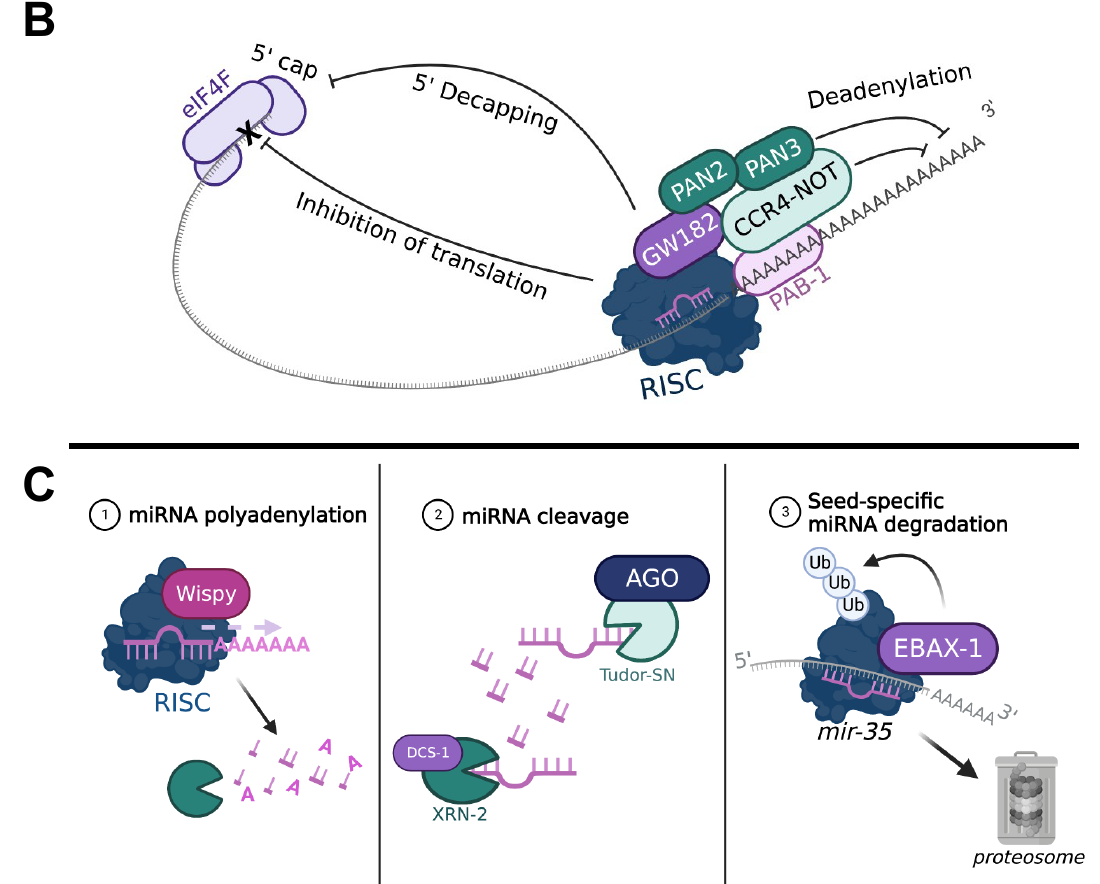
Figure 1. An overview of miRNA biogenesis, function, and decay. ( A ) The miRNA transcript undergoes several cleavage steps (scissors) by various endonucleases, Drosha/Pasha and Dicer. The miRNA is loaded onto an argonaute protein (AGO) with the help of chaperone proteins (Hsc70/Hsp90); after miRNA strand selection occurs, the miRISC complex is formed. ( B ) miRNA binding to the 3 (cid:48) UTR of an mRNA recruits the adaptor protein GW182, followed by the deadenylases and poly-A binding proteins CCR4-NOT, PAN2, PAN3 and PAB-1. Recruitment of these proteins induces translational repression by interfering with 5 (cid:48) cap-binding protein complex eIF4F, 5 (cid:48) de-capping, or deadenylation in the 3 (cid:48) poly-A region. Adapted from Ref. [19]. ( C ) miRNA turnover is induced by either the addition of several A nucleotides by poly-A polymerases (e.g., Wispy) at the 3 (cid:48) end of the miRNA (left panel), cleavage by nucleases such as XRN-2 or Tudor-SN (middle panel) or seed-sequence-specific targeting mechanisms such as the recruitment of the ubiquitin ligase EBAX-1(right panel). See text for further